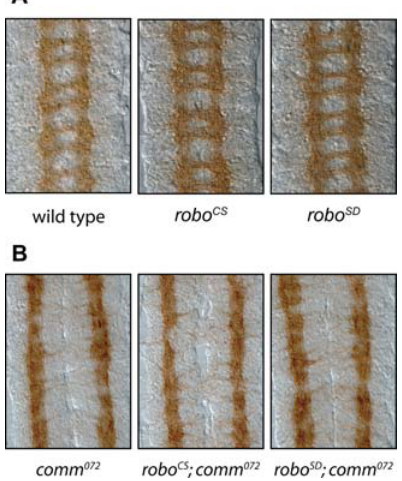
Figure 5. Wild type CNS Phenotype of Robo SD targeted alleles. (A) Embryonic CNS phenotype of targeted alleles as reveled by BP102 staining. All modifications show a wild type looking CNS. (B) BP102 staining of embryonic CNS of Robo SD targeted alleles in a comm mutant background.